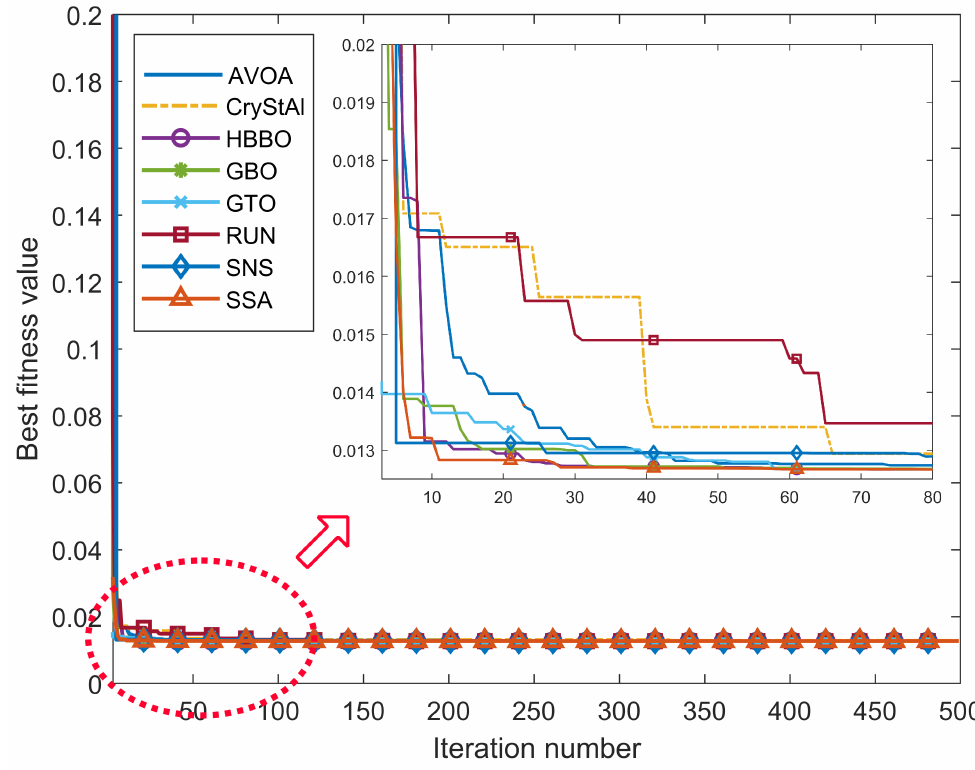
Figure 2. Best run convergence curves of each meta-heuristic algorithms (out of 100 repetitions) in the tension/compression spring design optimisation problem.